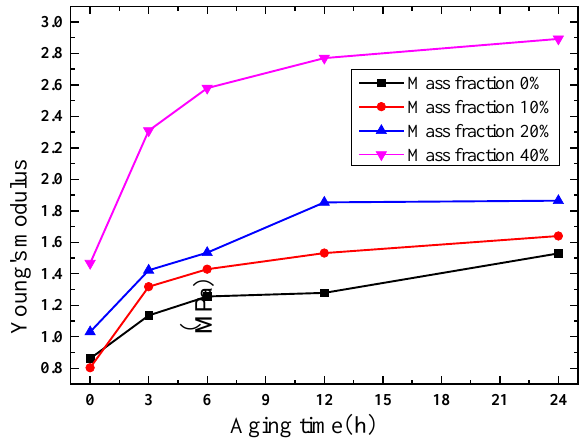
Figure 11. Elastic modulus of silicone under different conditions (strain rate: 8 × 10 − 4 /s).